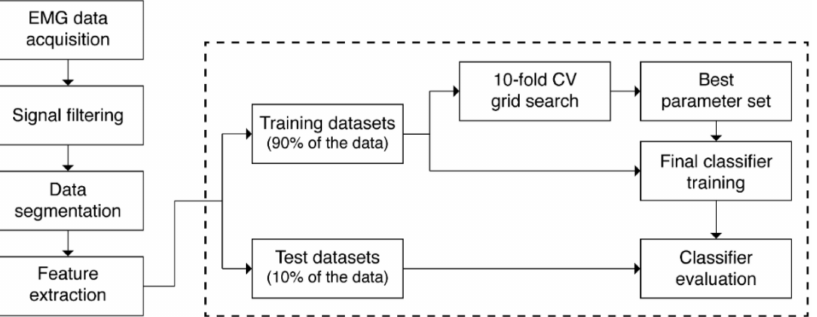
Figure 5. Flow chart of data processing steps.